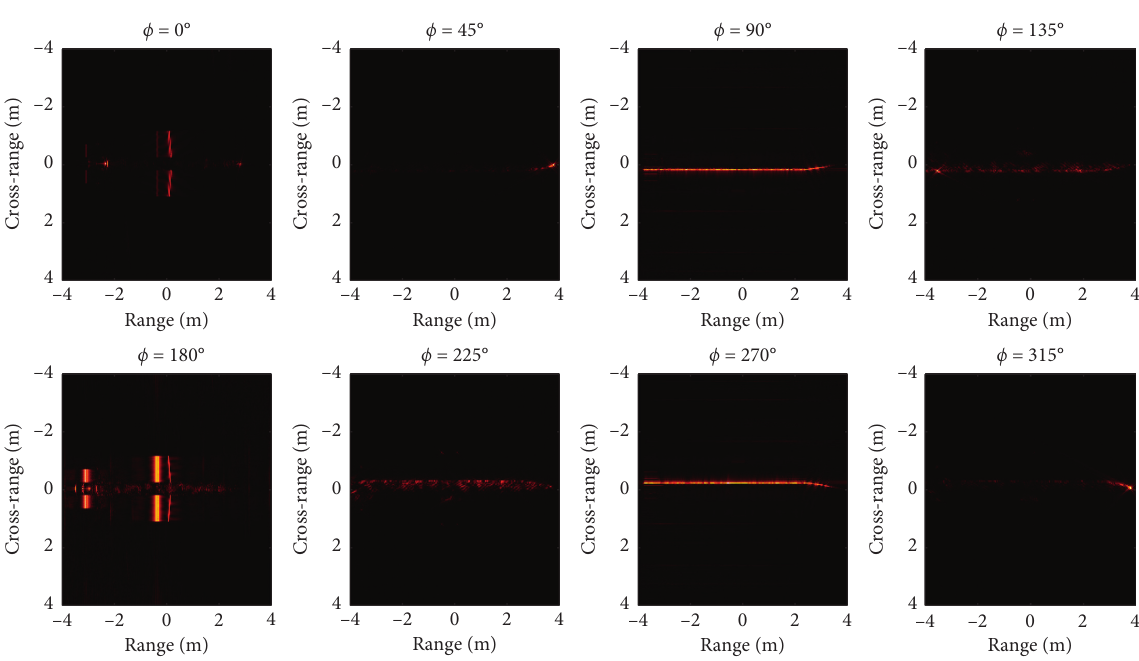
Figure 13: Subaperture images after